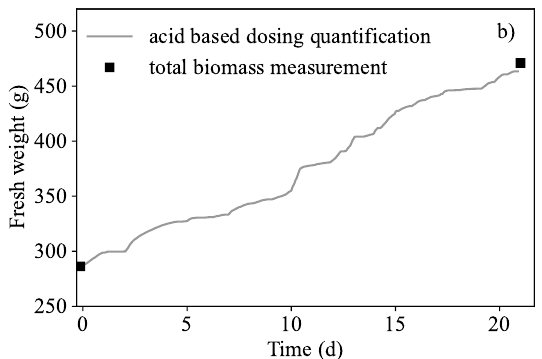
Figure 7. Growth quantification results in the semi-continuous run. ( a ) The relationship between absorbed nitrogen and dosed protons ( λ ) was re-determined to be 1.08 mol N · (mol H + ) − 1 indicated by the slope. Initial and final biomass measurement were 286 g and 470 g respectively. ( b ) Biomass prediction of biomass to show mass gained from the uptake of nitrogen with a percentage error of